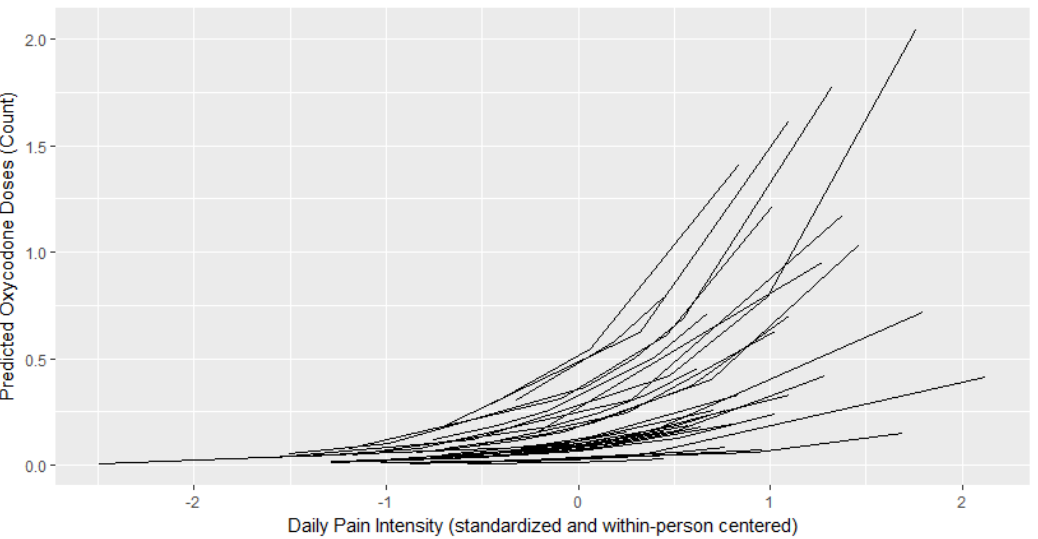
Figure 1. Within-person relationship between a child’s daily pain intensity and predicted oxycodone doses administered. Daily pain intensity is within-person centered where a higher score indicates greater pain intensity on a given day compared to a child’s average across the postoperative period.